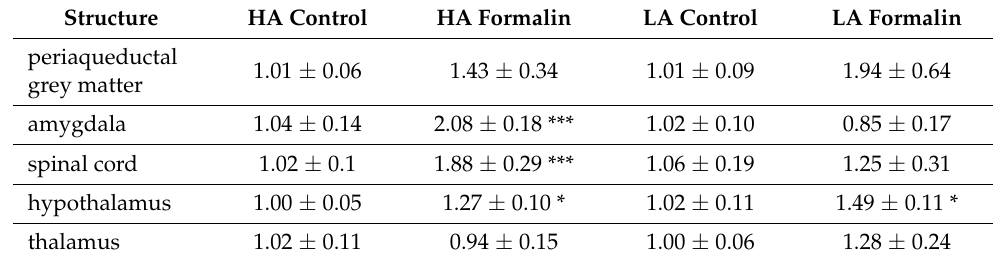
Table 1. Cannabinoid receptor 1 (Cnr1) mRNA levels in HA and LA mice in the interphase of the formalin test. Mice were injected with 5% formalin (in PBS) into the dorsal aspect of the hind paw ( n = 4–6). Samples were harvested 15 min post-formalin. Results were analysed within each line with two-way ANOVA followed by Bonferroni’s post-hoc test. Statistical significance was depicted as follows: * p ≤ 0.05; *** p ≤ 0.001 (vs. control).